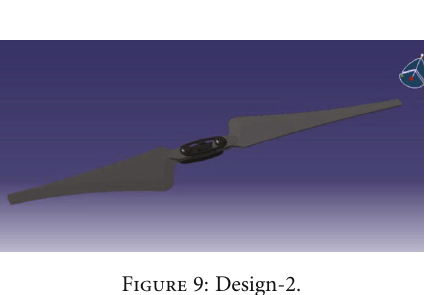
Figure 9: Design-2.